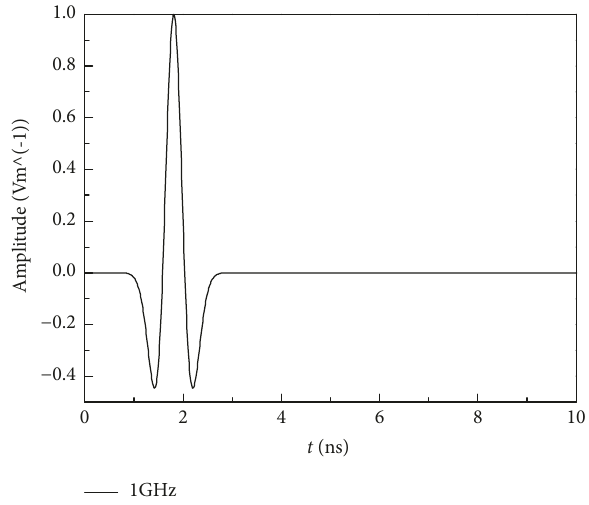
Figure 9: A Ricker wavelet for a dominant frequency of 1 GHz and unity amplitude.